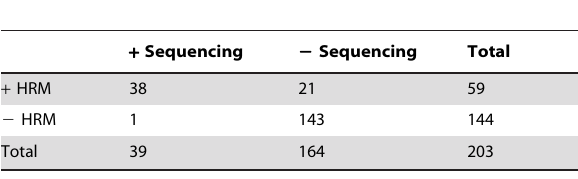
Table 3. Comparison between HRM mutation screening (initial screen) and sequencing of frozen